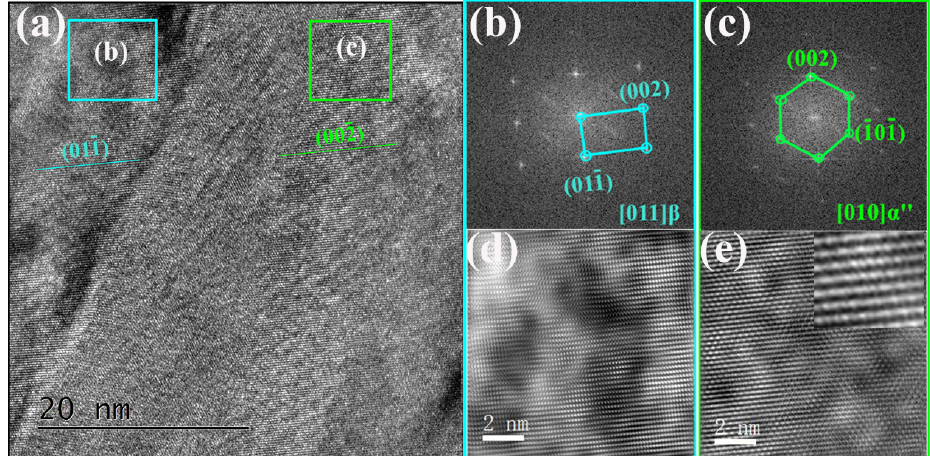
Figure 4. ( a ) HRTEM image of the α ” phase; ( b , c ) the FFT patterns of areas b and c in Figure 4a; ( d , e ) the corresponding Fourier filtered HRTEM images of areas b and c.